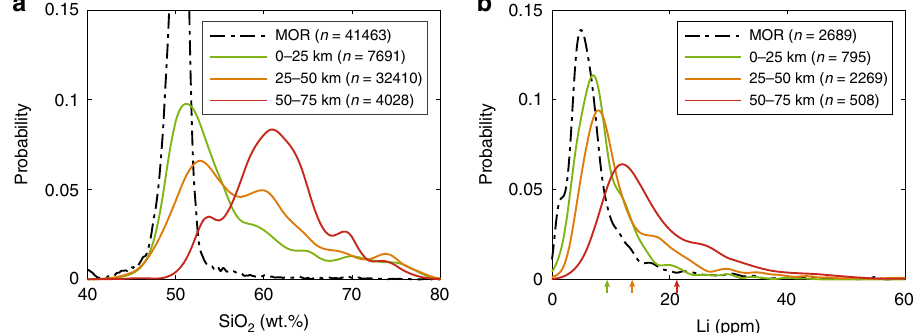
Fig. 4 Effects of crustal thickness on magmatic differentiation and Li enrichment. Probability distribution of SiO 2 ( a ) and Li concentrations ( b ) for arcs of different crustal thicknesses. Mid-ocean ridge (MOR) magmas shown as a reference. Colored arrows in ( b ) represent average Li concentrations for each crustal thickness